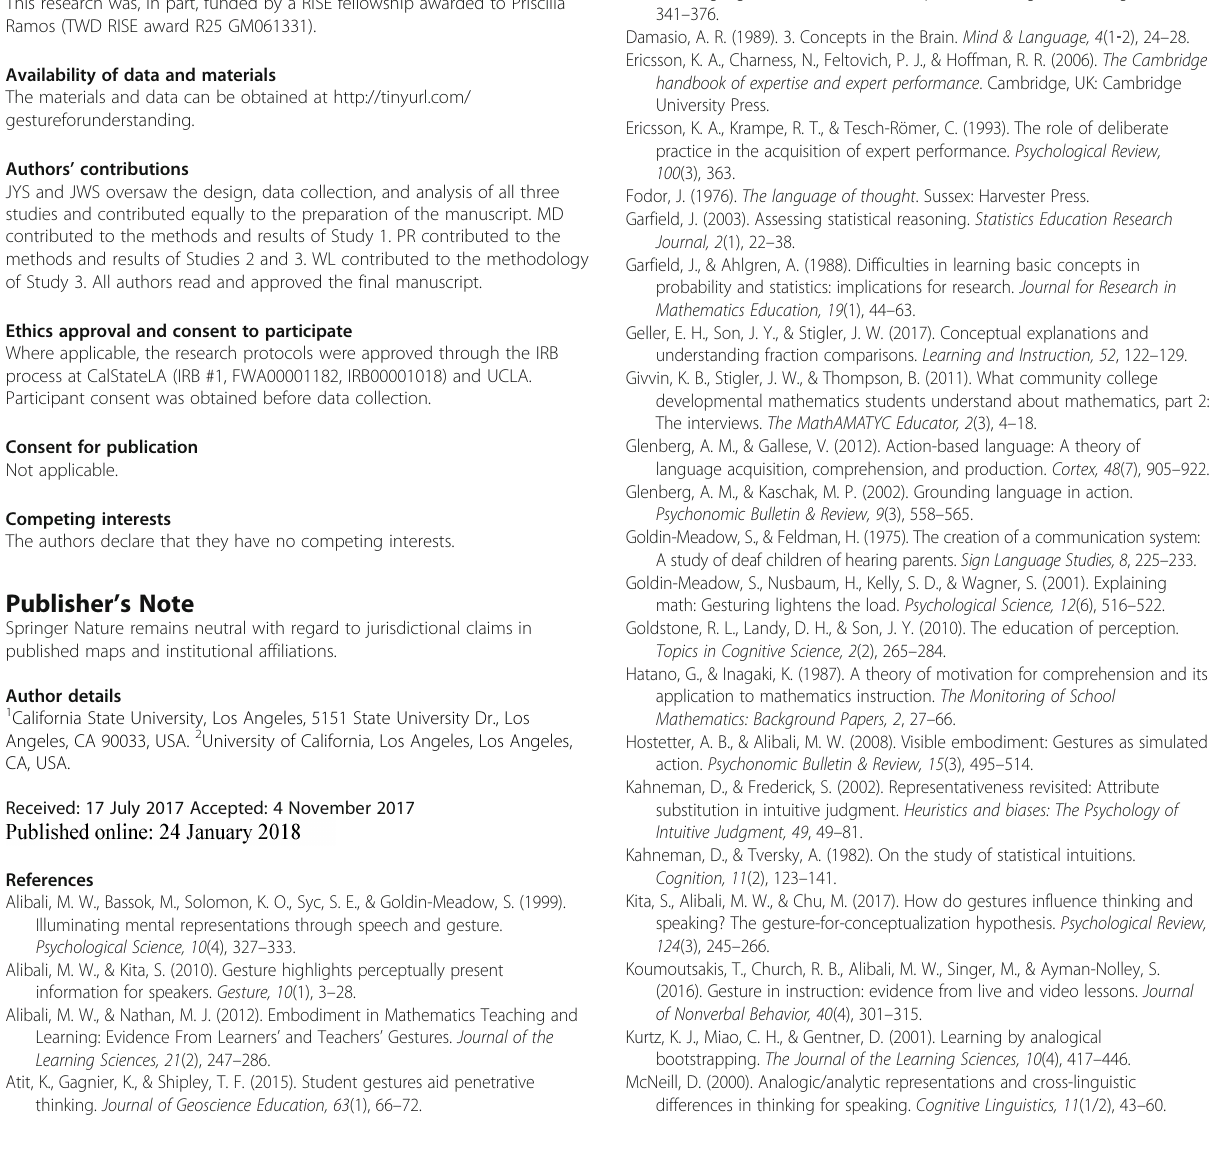
(cid:1) Chopping with hand in middle of space to show mean (cid:1) Showing “ all your data ” by encircling space in front of body with both hands (cid:1) Using one hand to indicate each row of an imaginary data sheet (pausing at each row) (cid:1) Closing the hand over an equation to indicate that, after computing, we will be left with one value (cid:1) When mentioning symmetry, moving hand in a vertical up and down axis to indicate vertical axis of